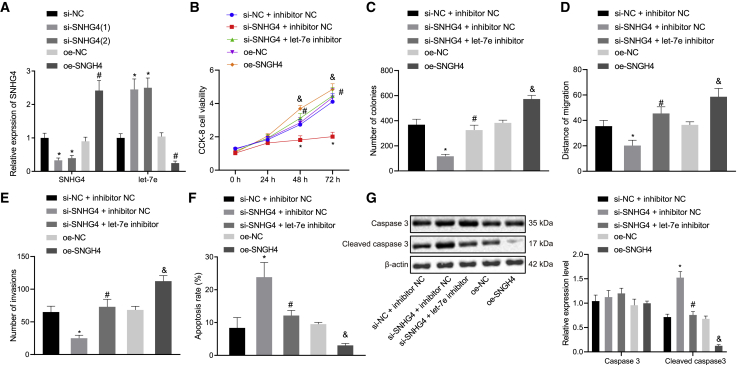
lncRNA SNHG4 mediates H1299 cell proliferation, migration, invasion, and apoptosis by binding with miR-let-7e(A) Expression of lncRNA SNHG4 and miR-let-7e after knockdown of lncRNA SNHG4 in H1299 cells. (B) H1299 cell viability measured by CCK-8 assays. (C) Numbers of colonies derived from H1299 cells. (D) Scratch wound healing. (E) H1299 cells invading from Matrigel-coated upper transwell chambers into lower ones. (F) H1299 cell apoptosis determined by annexin V/PI-labeled flow cytometric analysis. (G) Western blots and quantification of caspase-3 and cleaved caspase-3 in H1299 cells, normalized to β-actin expression. ∗p < 0.05 (compared with H1299 cells treated with scramble siRNA alone and/or inhibitor NC), #p < 0.05 (compared with H1299 cells treated with oe-NC alone or lncRNA SNHG4-specific siRNA plus inhibitor NC), and &p < 0.05 (compared with H1299 cells treated with oe-NC alone) by Tukey’s test-corrected one-way ANOVA or Bonferroni-corrected repeated-measures ANOVA.